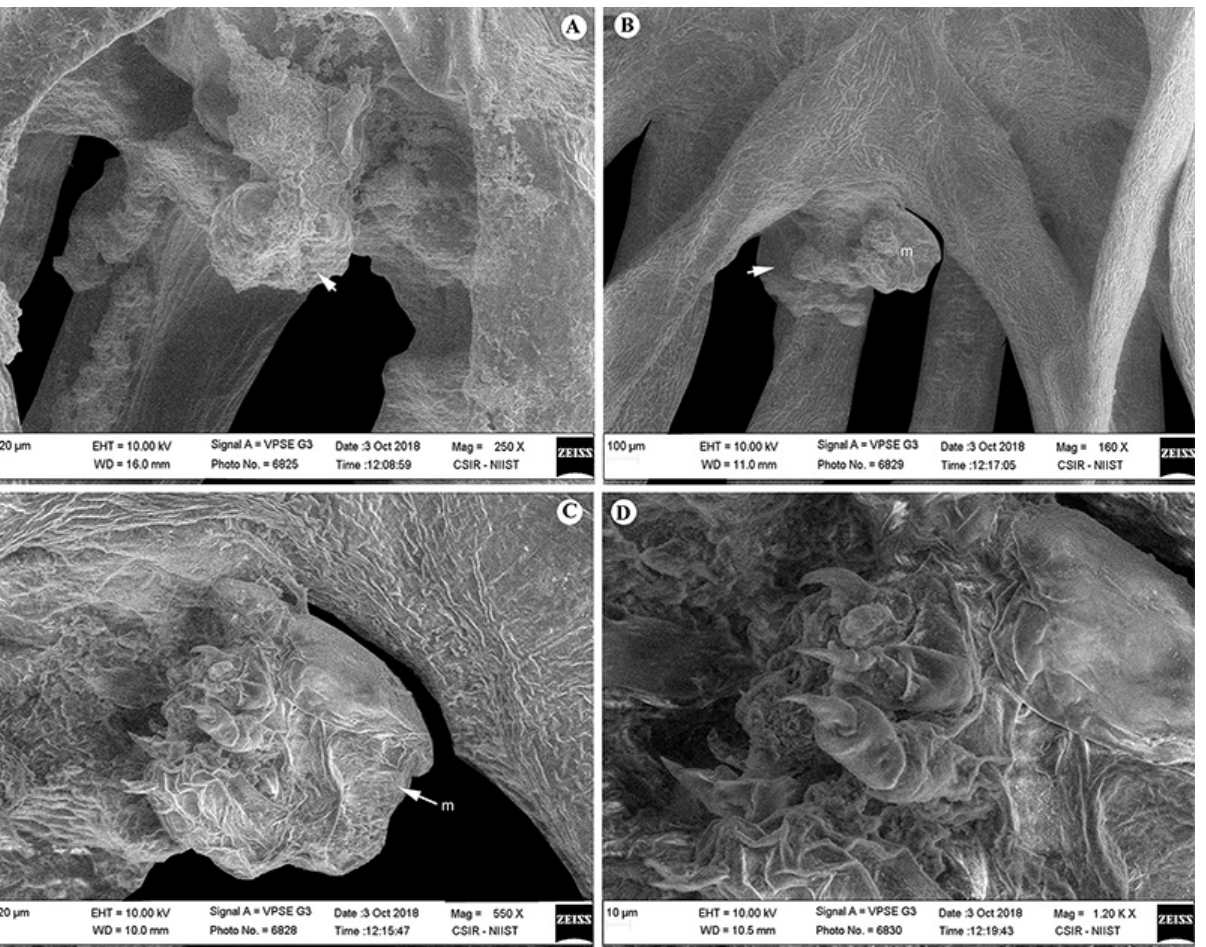
Figure 13. Scanning electron micrographs of Chondracanthus kabatai sp. n. from Zenopsis conchifer Lowe. A . Genito-abdomen ventral view (arrow). B – D . Male attached to genito-abdomen of female. (m-